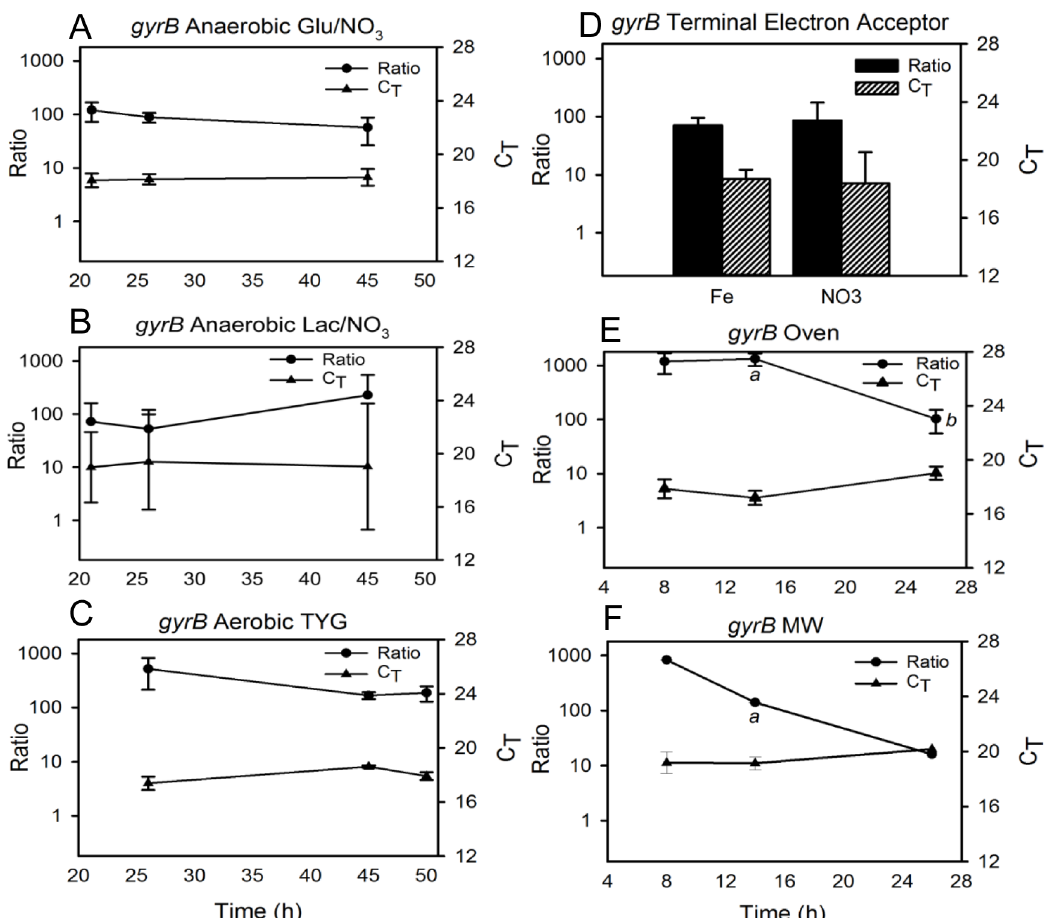
Fig 3. Correlation between gyrB transcript C T values and gene expression as derived from the transcript-to-gene copy number ratios. A standard curve was constructed and used to calculate the transcript copies per mL of sample and gene copies per mL of sample ( “ transcript-to-gene ratio ” ) under the different culture conditions described in the text. Ratio and C T values obtained for gyrB under: anaerobic growth with (A) glucose or (B) lactate as carbon source compared to (C) small-volume aerobic growth in TYG; (D) anaerobic growth with glucose as carbon source and nitrate or iron as terminal electron acceptor; and aerobic growth in TYG using (E) oven or (F) microwave heating. Glu = glucose, Lac = lactate, MW = microwave heating. a = indicates statistically significant difference (p < 0.05) among different culture conditions at specific time points; b = indicates statistically significant difference (p < 0.05) across time under one culture